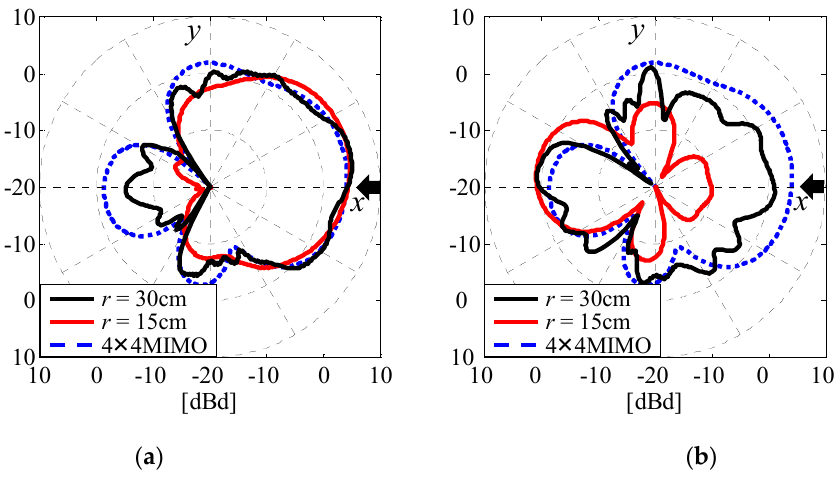
Figure 11. Radiation patterns of Subarray2 and Subarray18 when the 32 × 32 MIMO antenna is used. ( a ) Subarray2. ( b ) Subarray18.